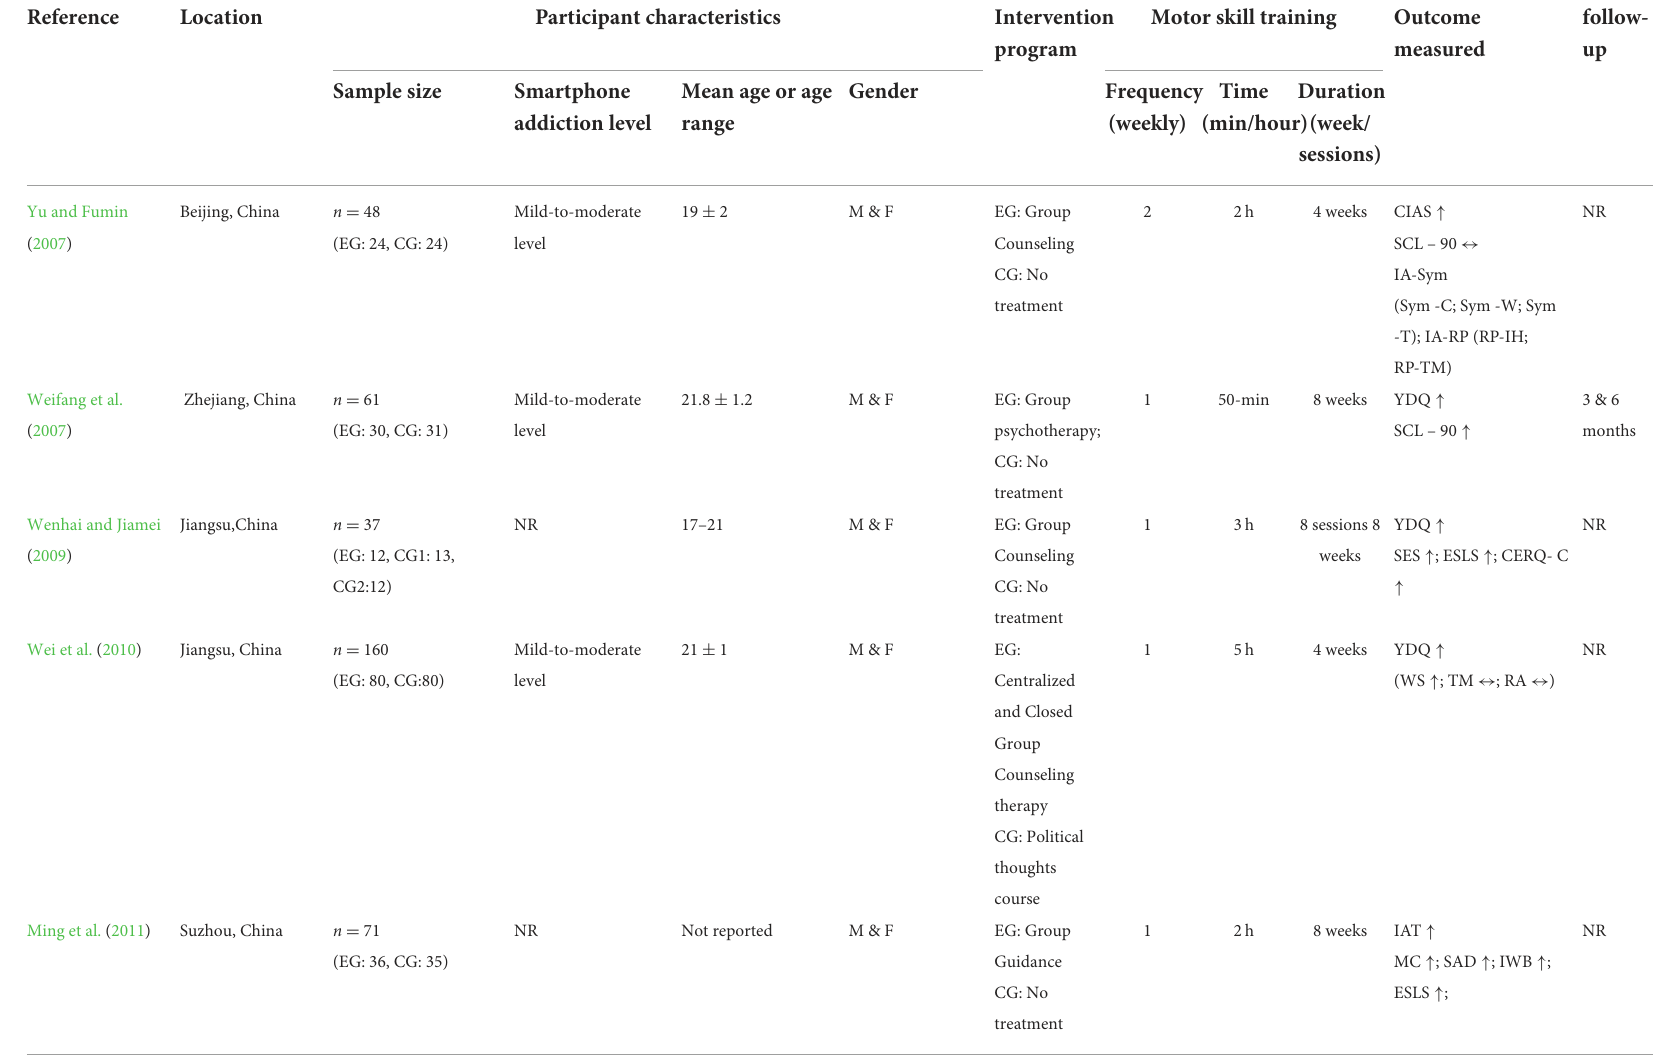
TABLE 3 Overview of psychosocial intervention with smartphone